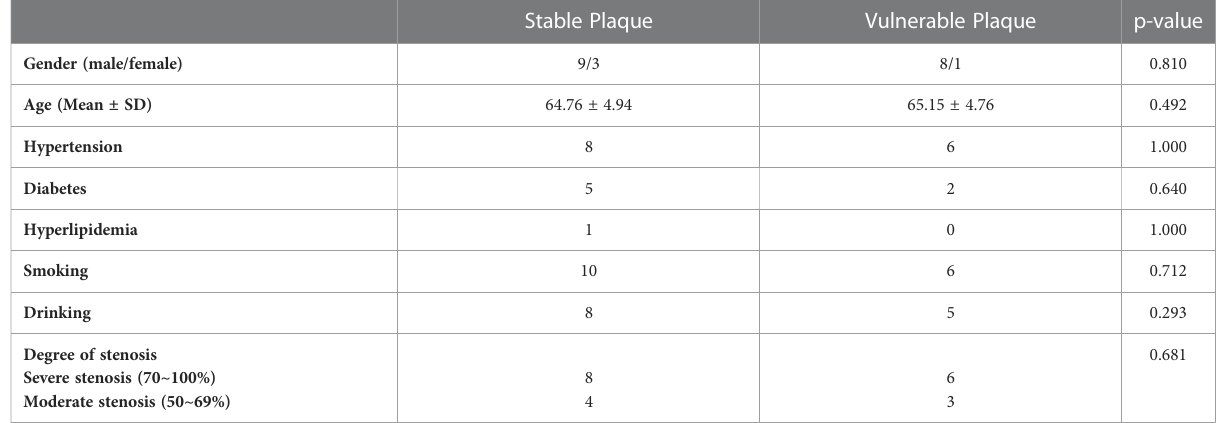
TABLE 1 Clinical characteristics of the patients.